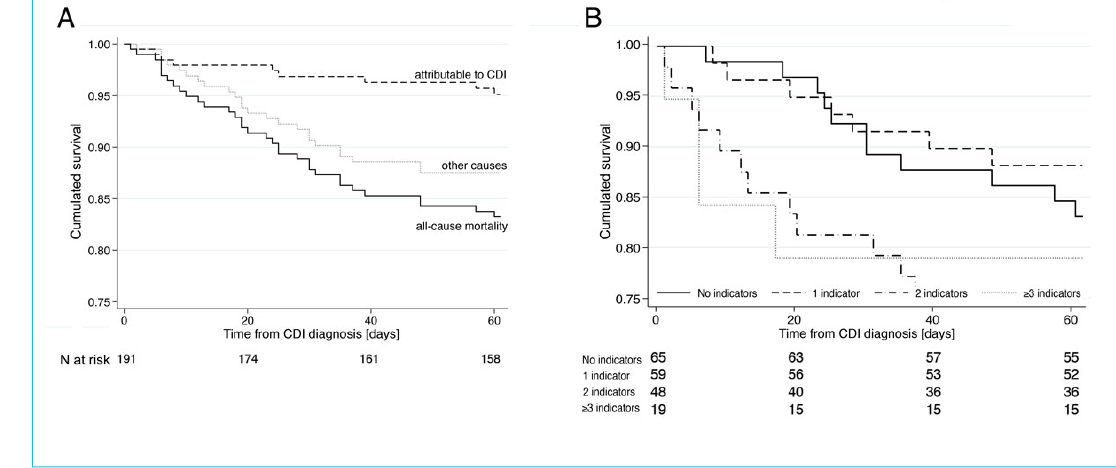
Figure 3: A: Kaplan-Meier curve showing all cause 60-days-mortality (solid), mortality attributable to Clostridioides difficile infections (CDI, dashed) and mortality related to other causes (dotted). B: Overall mortality by number of indicators for severe CDI (temperature ≥38.5°C, leu-